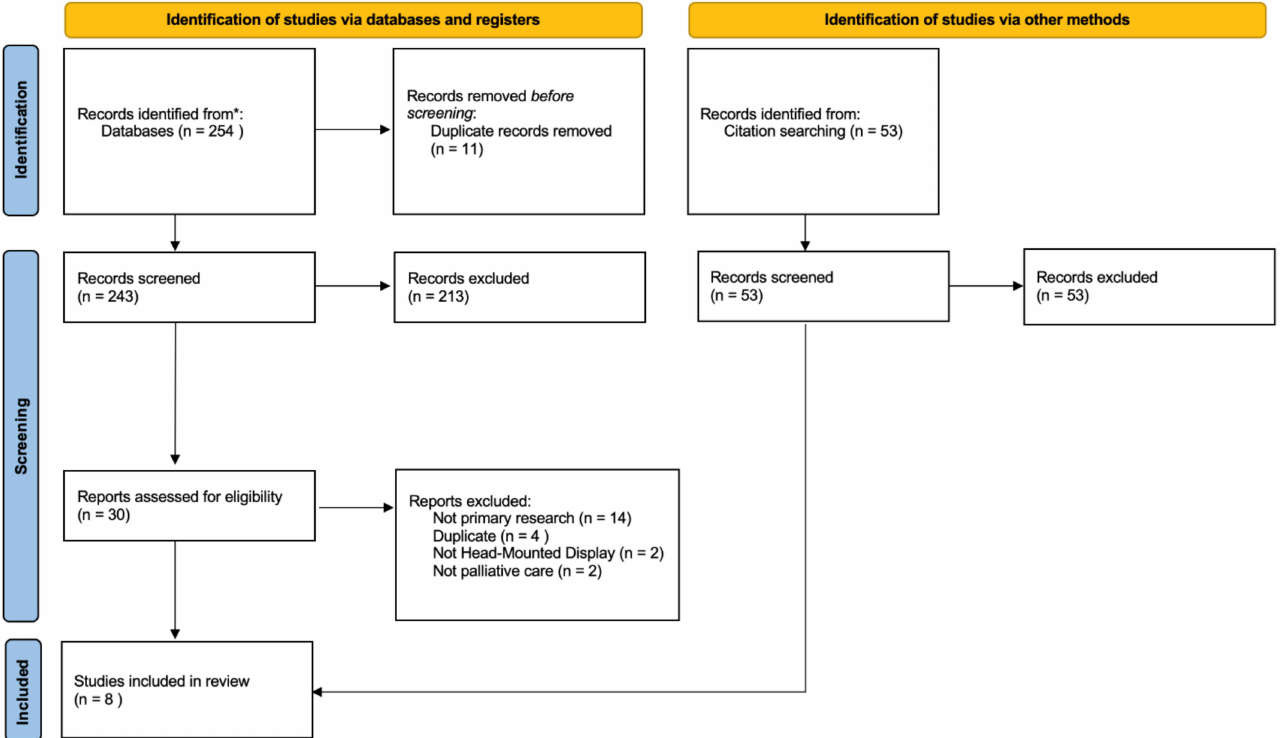
Figure 1. PRISMA Search Flow